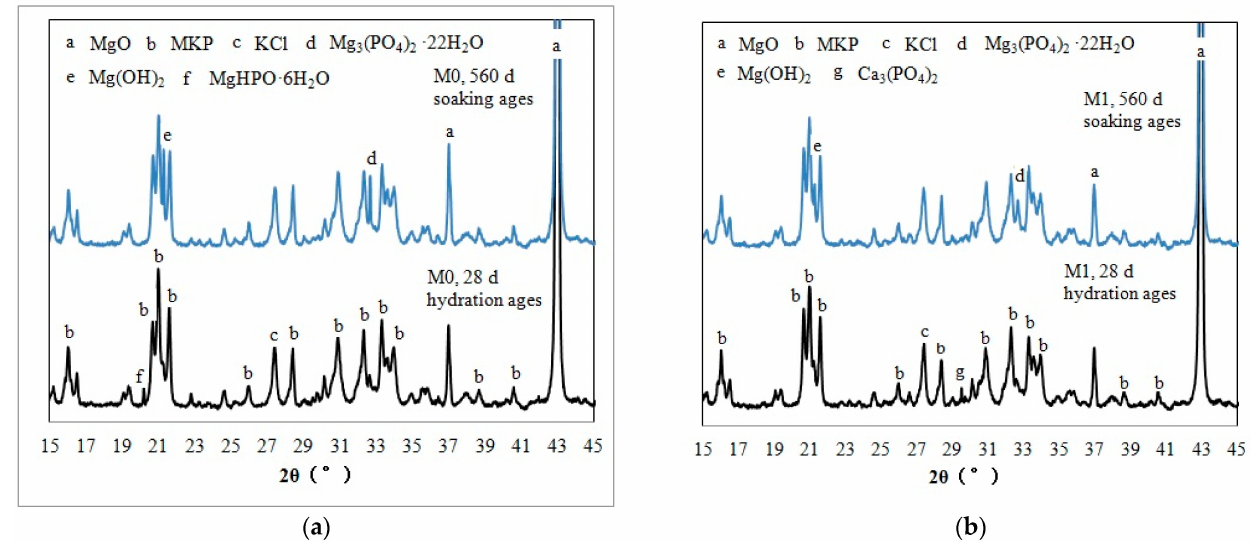
Figure 4. XRD patterns of the MKPC samples. ( a ) M0, ( b )